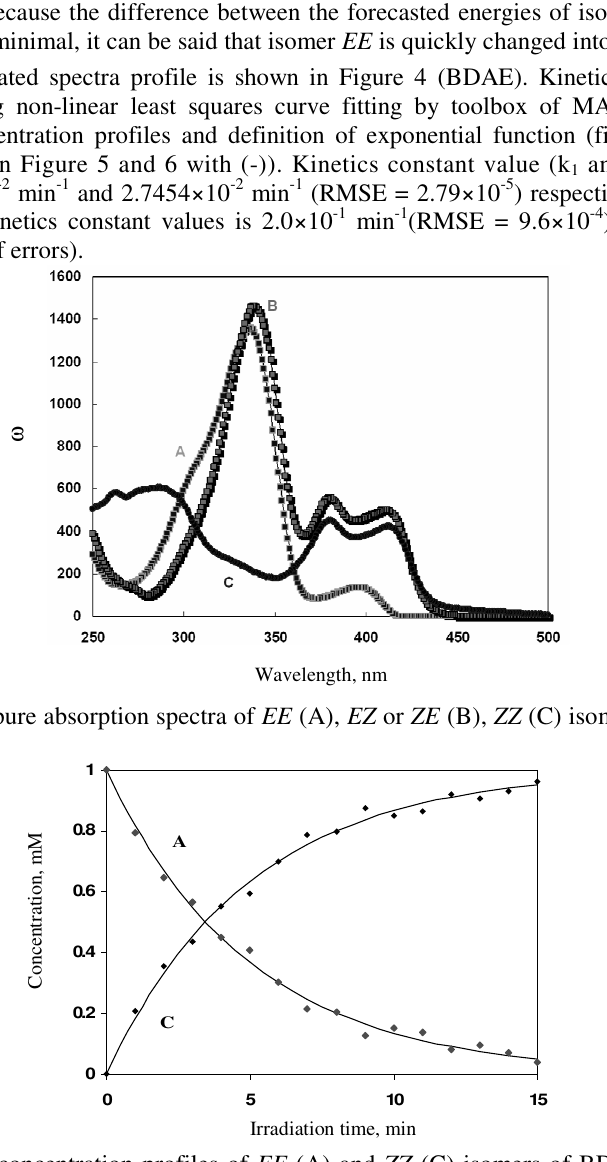
Figure 5. The concentration profiles of EE (A) and ZZ (C) isomers of BDAP (MCR-ALS ( ■ ) and fitted exponential function ( ―